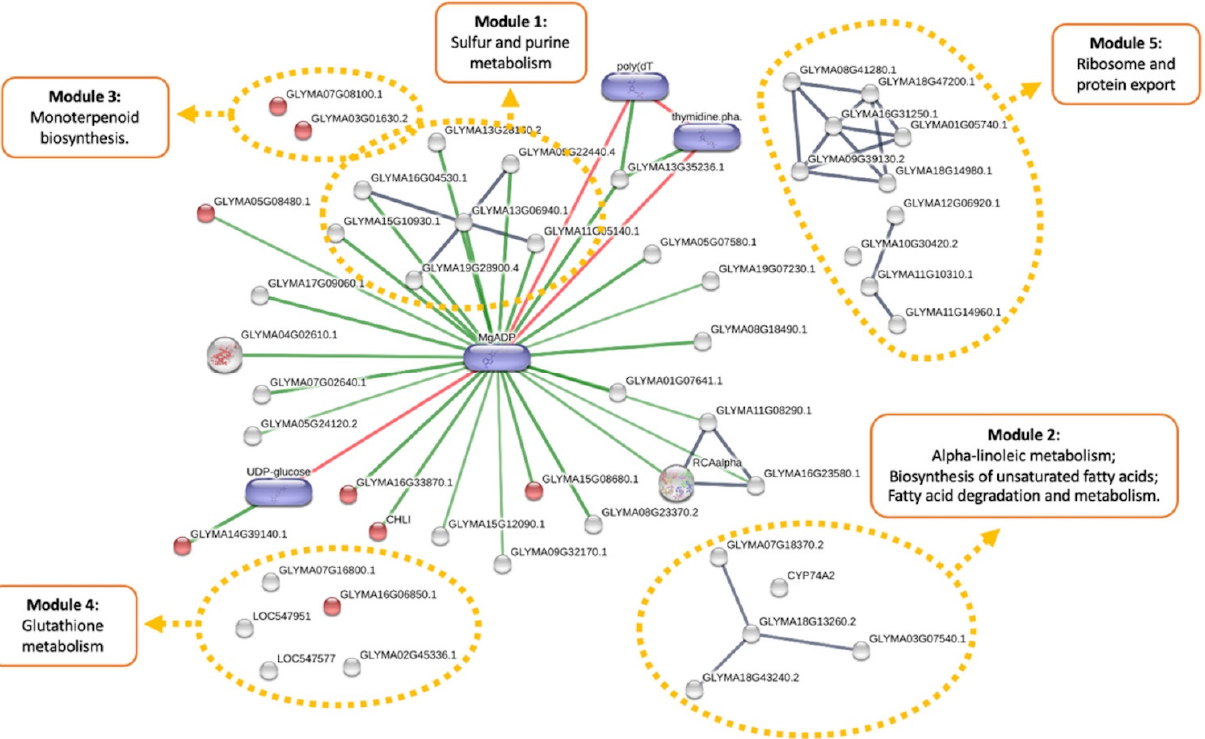
Figure 6. Biological network of differentially expressed proteins in response to combined herbicide and drought stress in GM soybean plants. The visual network was built using Stitch database. Functional modules are highlighted in orange dotted lines. Additional metabolites (purple) were added as functional partners in order to show network context. Stronger associations are represented by thicker lines. Protein-protein interactions are shown in grey, chemical–protein interactions in green and interactions between chemicals in red. Image is automatically retrieved from the Stitch software. No manual entries have been made.